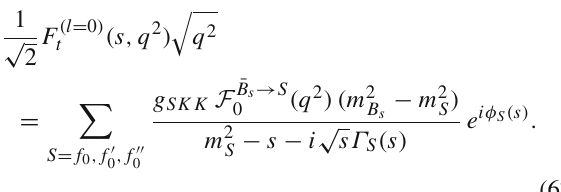
Table 2 The fitting result for F i in f 0 + f (cid:4)